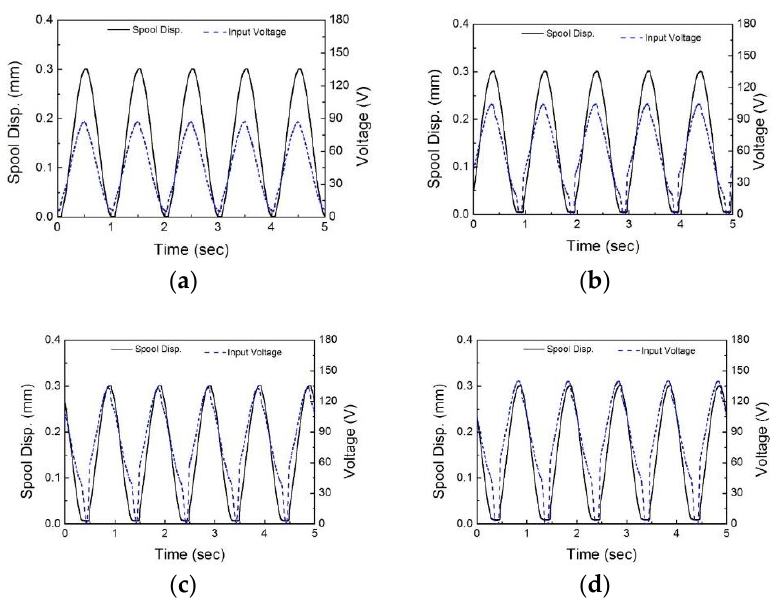
Figure 6. Influence of heat on the spool displacement without control action. (a) 30 °C, (b) 90 °C, (c) 110 °C, (d) 120 °C.